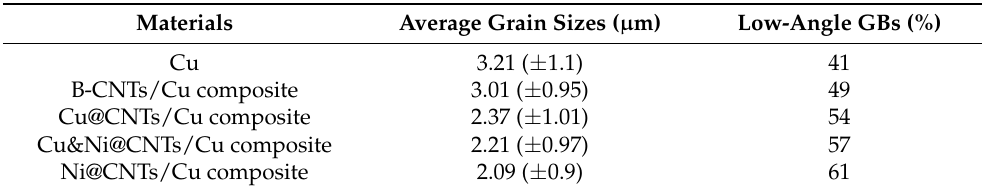
Table 5. Results of EBSD